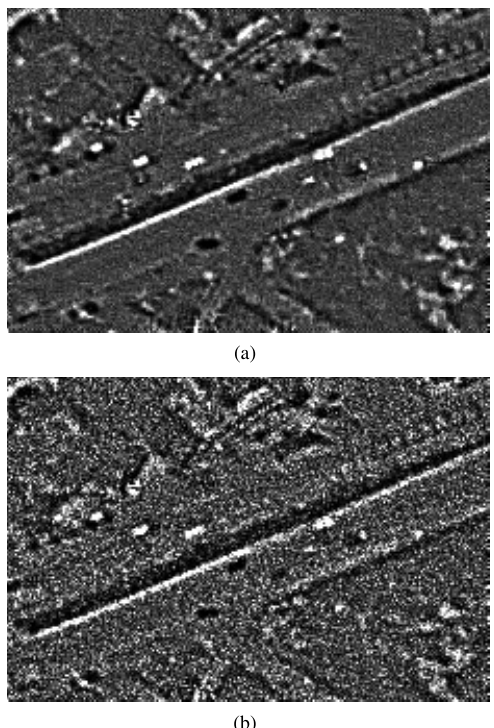
Figure 4: Effects of Gaussian noise.(a)Add Gaussian white noise of mean 0 and standard deviation 0.01. (b)Add Gaussian white noise of mean 0 and standard deviation